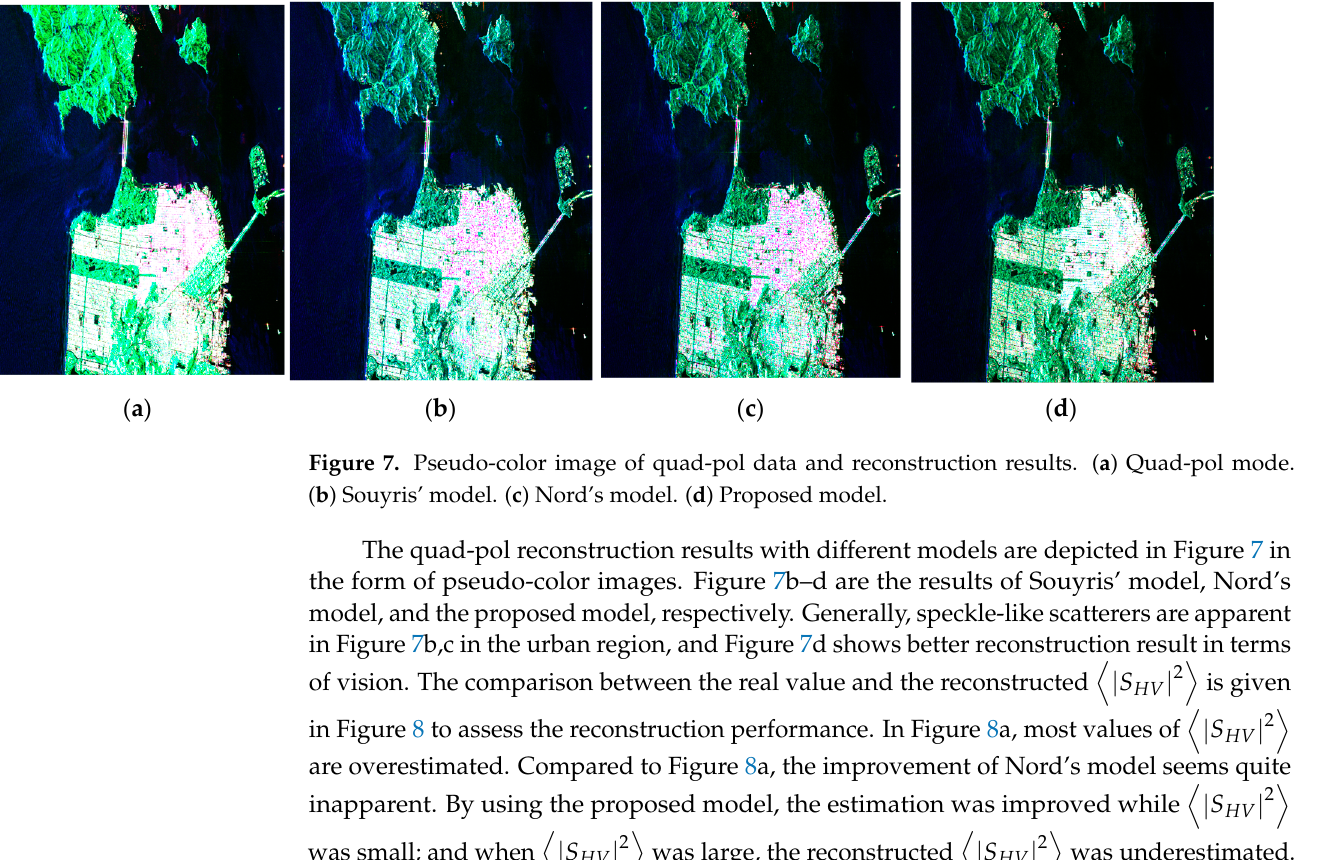
Figure 8. Comparison between the real value and the reconstruction results of 2 HV S . ( a ) Souyris’ model. ( b ) Nord’s model. ( c ) Proposed model. For further assessment, the logarithm relative error is depicted as Figure 9. The pro- posed model had a better effect on the overall scene. Obviously, the error value is closer to zero in Figure 9c. The reconstruction performance of the proposed model in both the ocean region and the urban region improved as compared to Figure 9a,b, and in urban areas in particular, the improvement was greater, which is consistent with the results of the Gaofen-3 data.